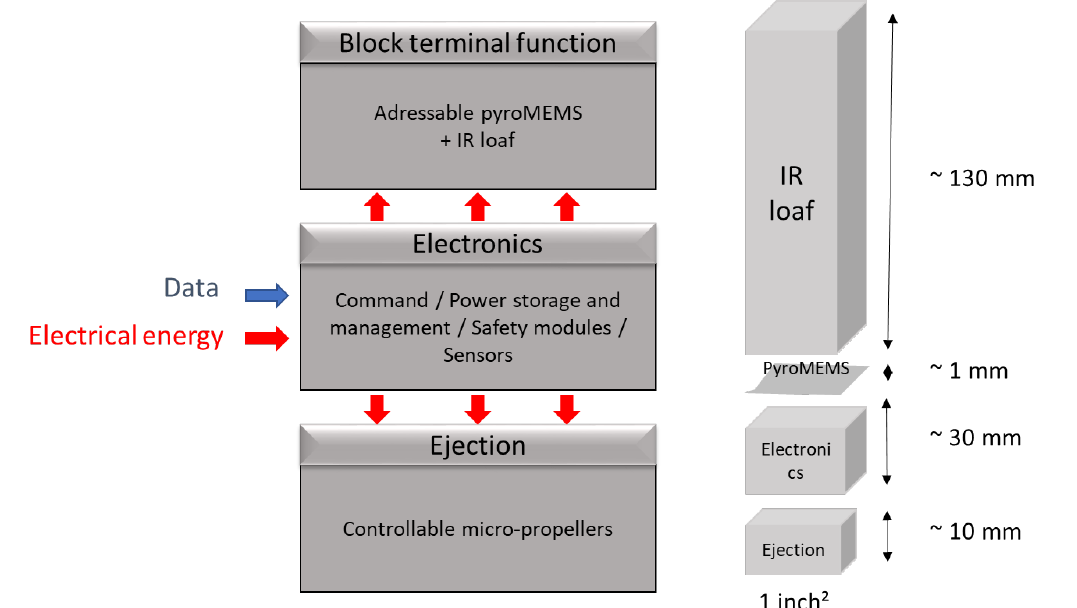
Figure 2. Smart IR flare structure: ( left ) block diagram and ( right ) the corresponding dimen- sions.